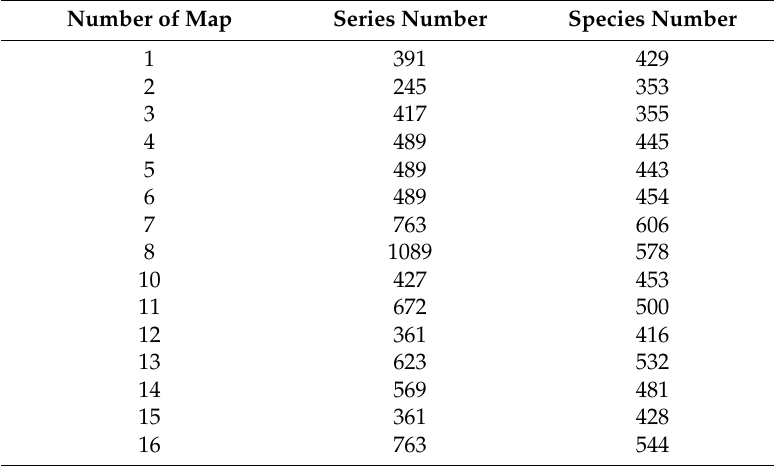
Table 1. Summary of total number of series and species detected for each zone. Number of Map Series Number Species Number 1 391 429